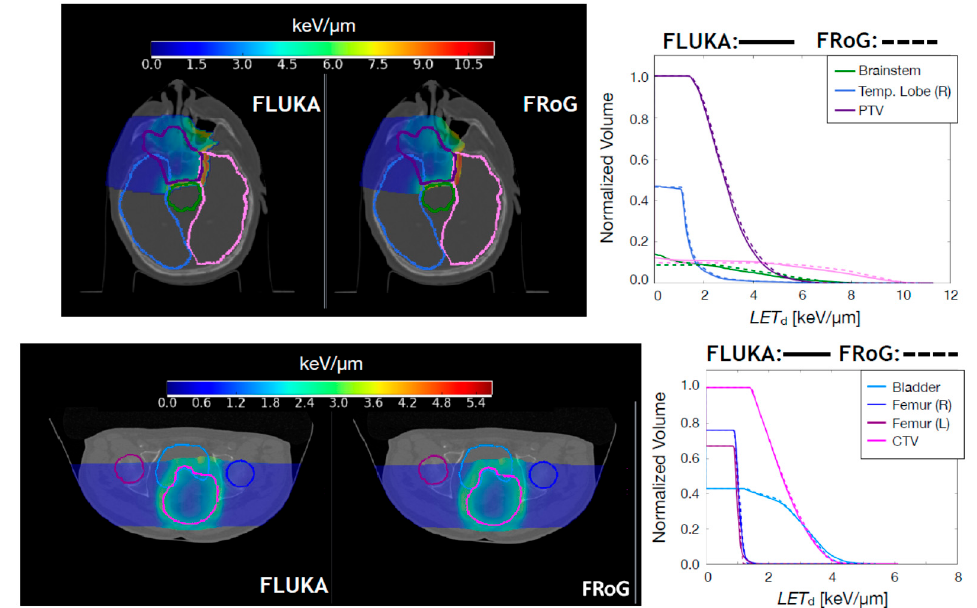
Figure 3. Upper panels: FLUKA and FRoG recalculated LET d distributions for a proton head case are displayed in the left and middle panel, respectively, together with the contours of four regions of interest: PTV, brainstem, and right and left temporal lobe. The LET d VH for the ROIs are shown in the right panel. Lower panels: FLUKA and FRoG recalculated LET d distributions for a proton pelvic case are displayed in the left and middle panel, respectively, together with the contours of four regions of interest: CTV, right and left femur, and bladder. The LET d VH for the ROIs are shown in the right panel.